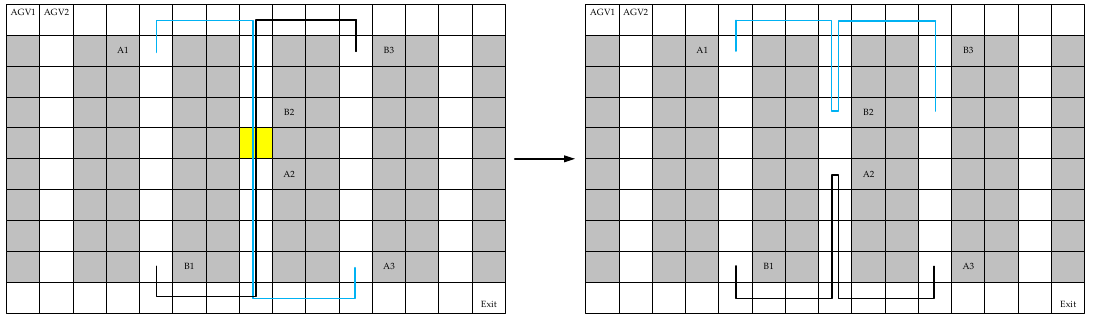
Figure 3. Driving paths before and after eliminating conflicts in opposite direction conflict.